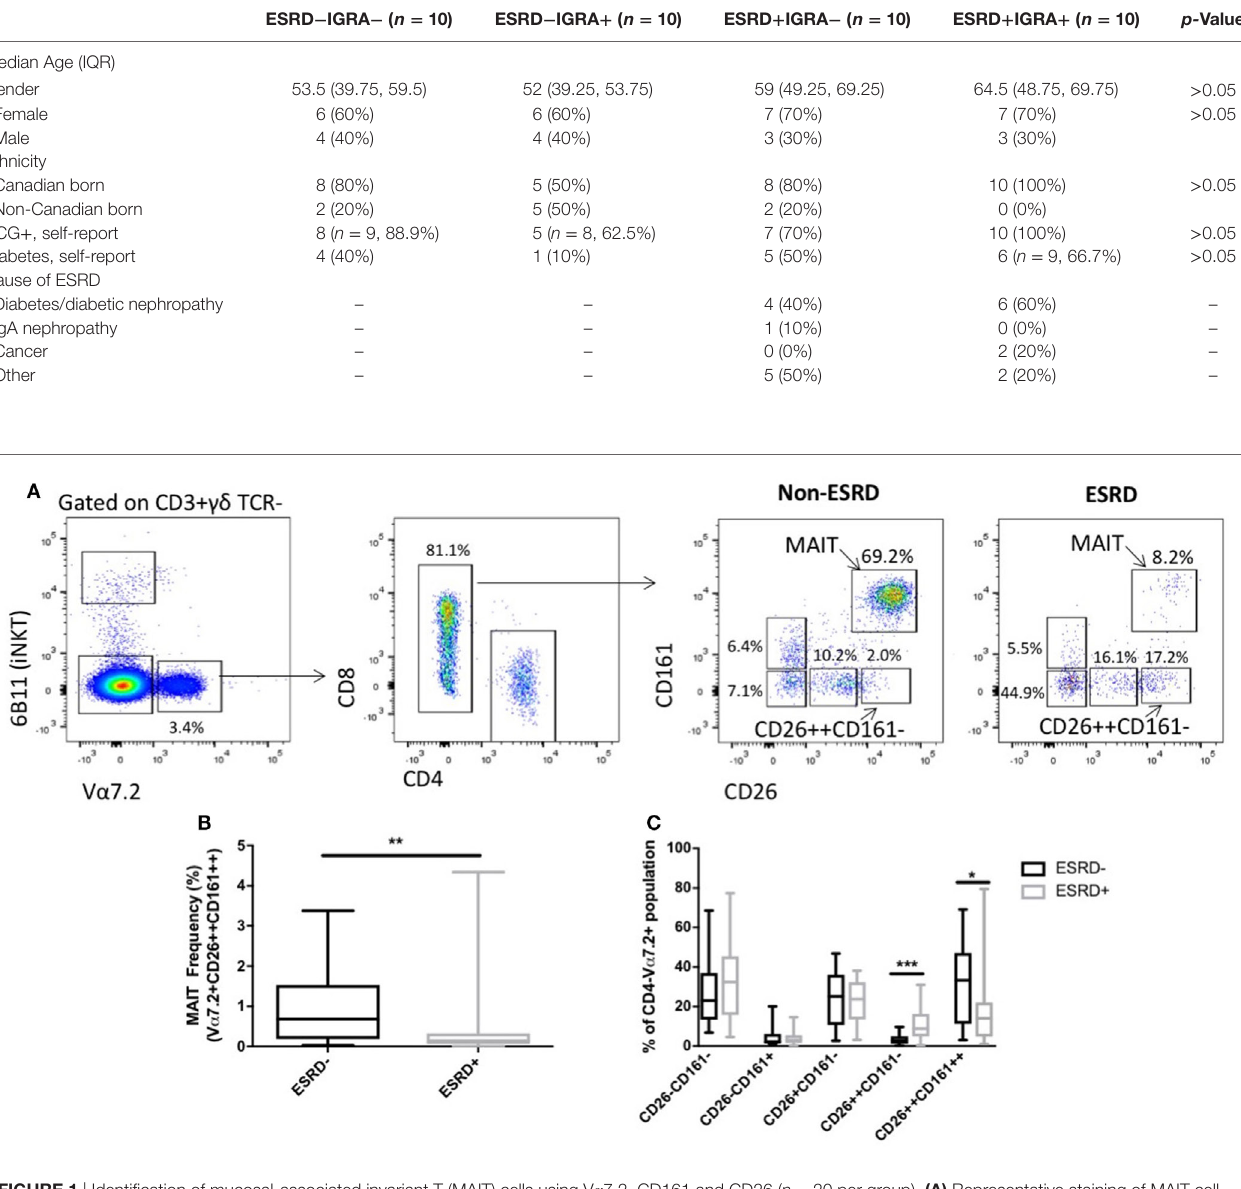
TaBle 1 | Characteristics of end-stage renal disease (ESRD) and non-ESRD participants, based on Interferon Gamma Release Assay (IGRA)